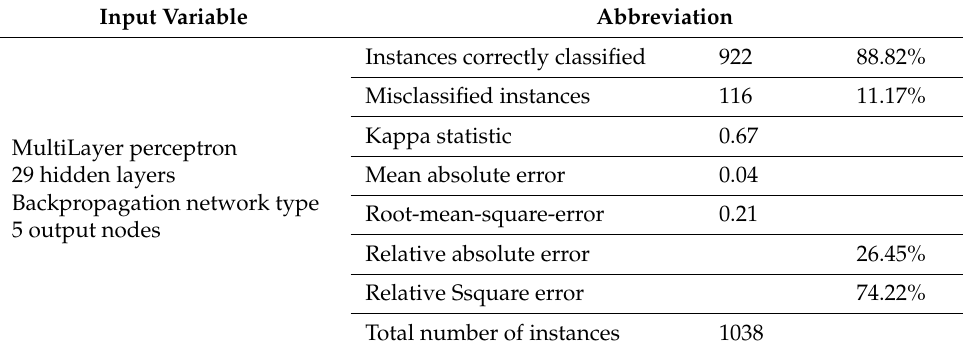
Table 2. Classification of the 25 pre-processed attributes.